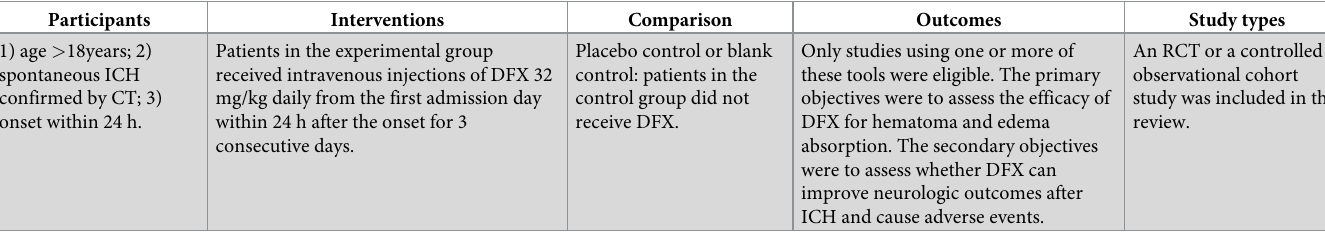
Table 1. Prespecified eligibility criteria. Participants Interventions Comparison Outcomes Study